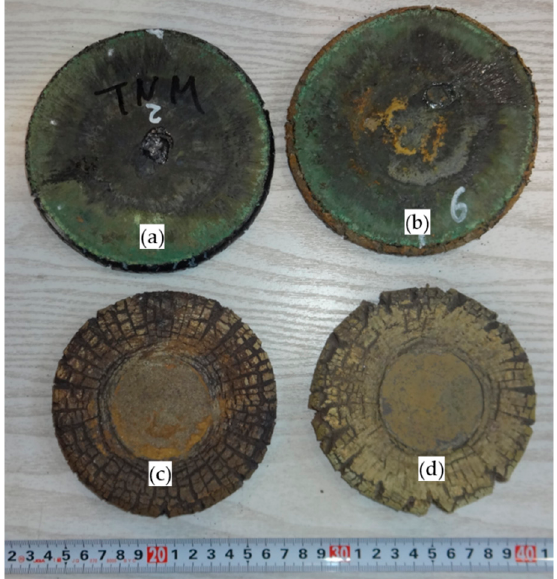
Figure 2. Examples of the fabricated forged materials: ( a ) TNM alloy (isothermal forging), ( b ) Ti- 44.0Al-3.1Cr (isothermal forging), ( c ) Ti-42Al-5Mn (hot-forging), and ( d ) Ti-42.0Al-3.4Cr (hot-forging).